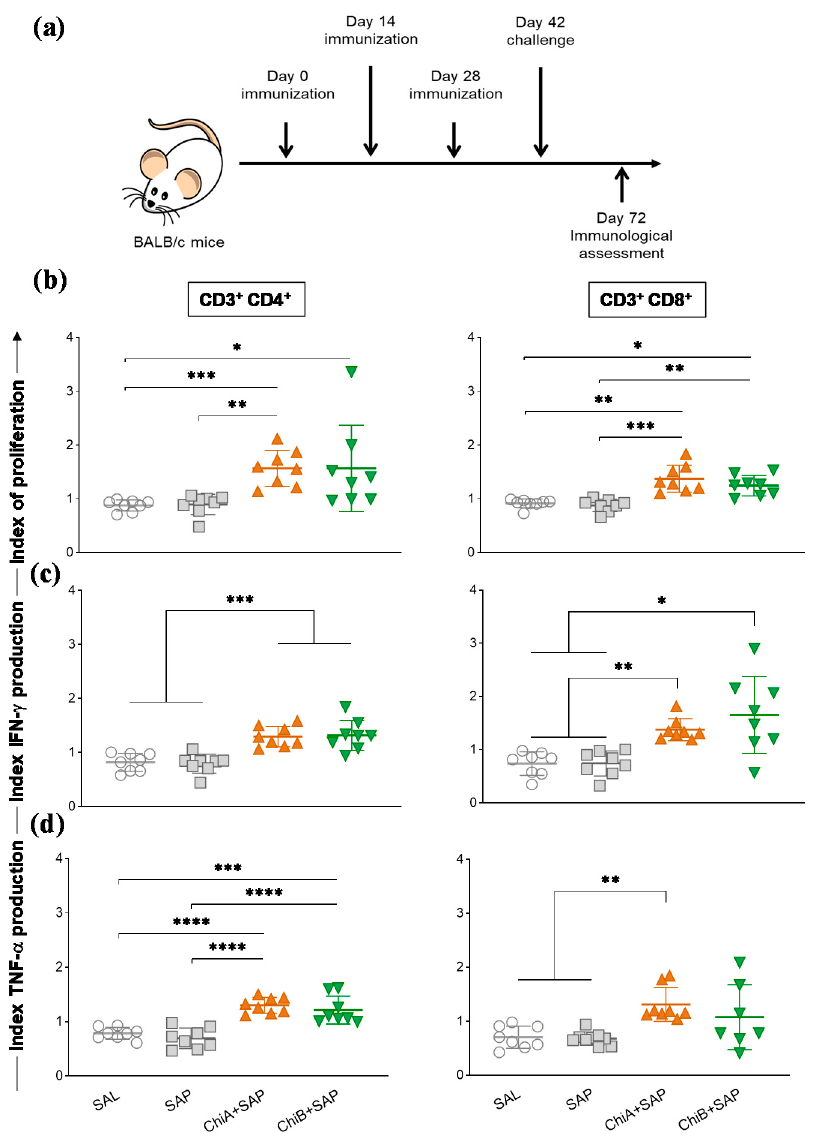
Figure 4. Splenic immune response after mice immunization with chimeric vaccines and challenge with L. infantum . ( a ) BALB / c mice were immunized three times and challenged with L. infantum promastigotes. Four weeks later, splenocytes were obtained and proliferation and intracellular cytokine production (IFN- γ and TNF- α ) were assessed through flow cytometry. ( b ) Graphs represent the index of T cell proliferation (culture index stimulated by the control culture (SC / CC) ratio) of T-CD4 + and T-CD8 + cells after in vitro stimulation with SLA (soluble Leishmania antigen). ( c ) Representation of IFN- γ and ( d ) TNF- α production indexes (SC / CC ratio) of T-CD4 + and T-CD8 + cells after in vitro stimulation with SLA. Indexes were calculated on the basis of SLA-stimulated (SC) cultures divided by the control culture (CC). Data are expressed as means ± SD of two independent experiments ( n = 8). The p -values represent the di ff erence between the groups: * p- value < 0.05, ** p- value < 0.005, *** p- value < 0.0005, and **** p- value <